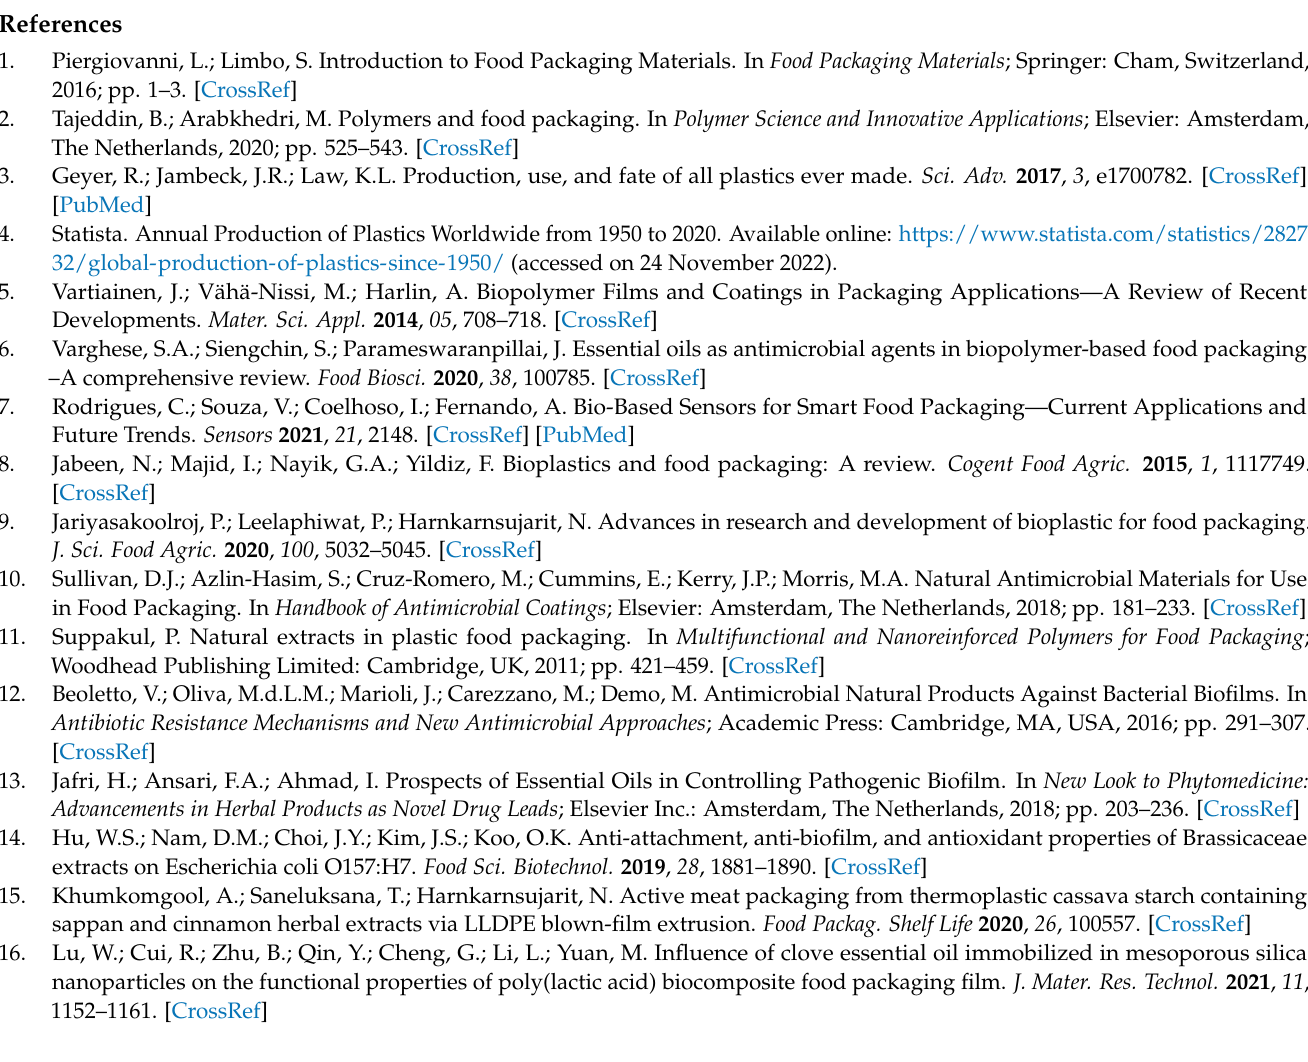
ate Figure 1, and Inkscape software, version 1.2.2 was used to generate the graphical